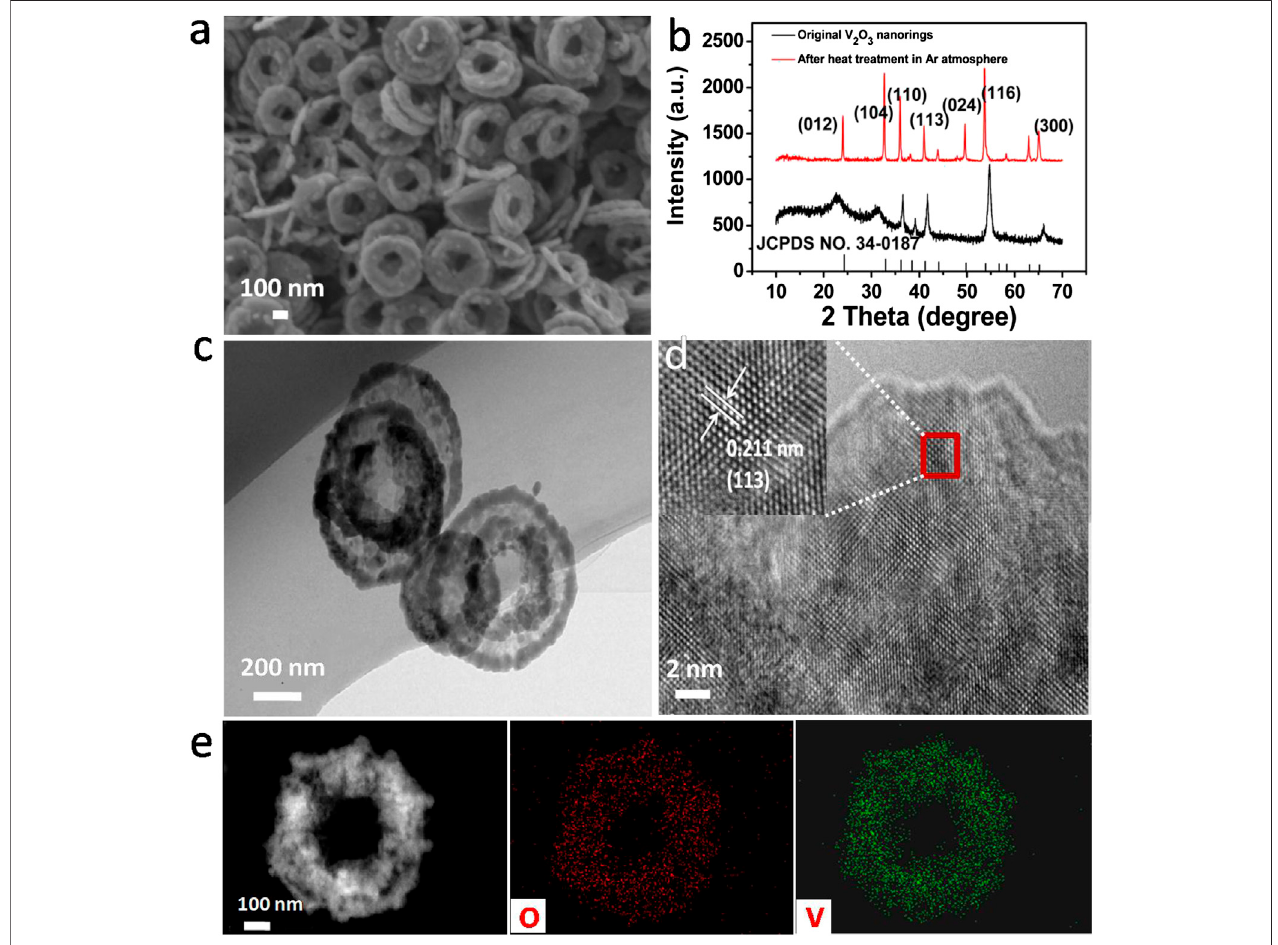
FIGURE 1 | (A) SEM image of the original V 2 O 3 nanorings. (B) XRD pattern of the original V 2 O 3 nanorings and the corresponding one after heat treatment in Ar atmosphere. (C) TEM and (D) HRTEM images of the original V 2 O 3 nanorings. (E) STEM image of the original V 2 O 3 nanoring and EDX elemental mapping of V and O.